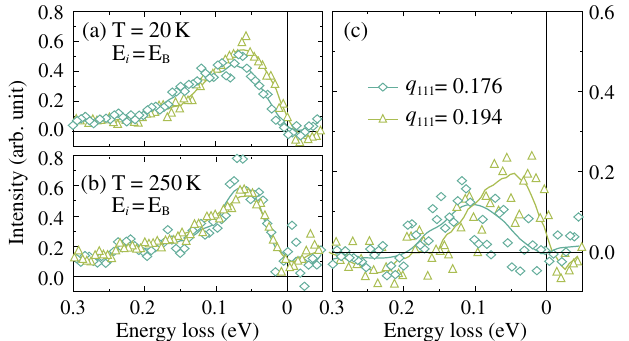
FIG. 3. Low-energy part of the RIXS spectra measured with E E at (a) 20 K and (b) 250 K after the subtraction of the i ¼ B elastic contribution. Panel (c) shows the magnon scattering intensity obtained by using the same procedure as in Fig. 2(c). The lines are a guide to the eye.